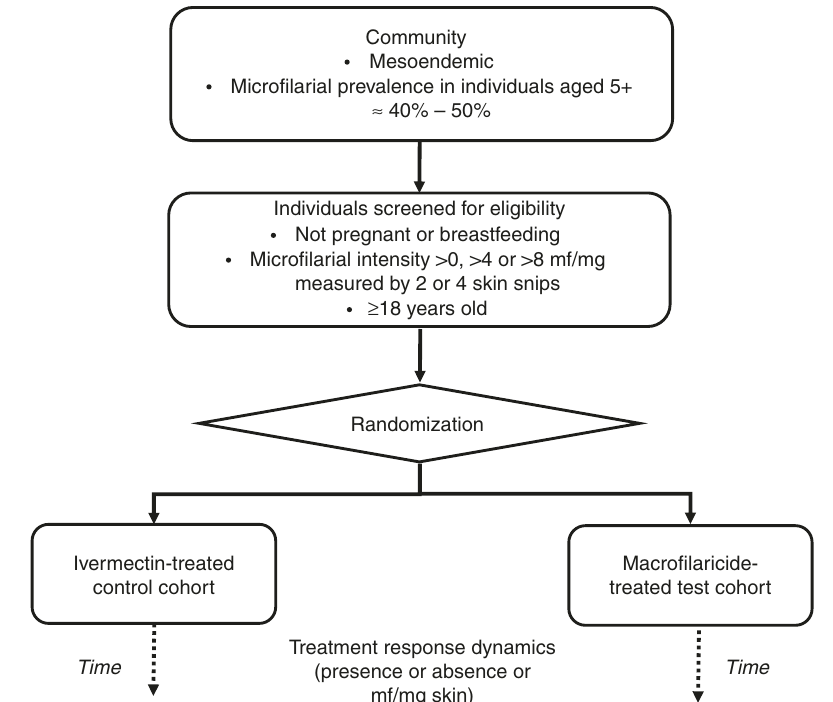
Fig. 1 Schematic representation of the simulated trial design. The simulated trial is conducted in a community previously ivermectin-naïve residing in a lower-end mesoendemic setting with a micro fi larial prevalence among individuals aged ≥ 5 years of 40% to 50%. It is assumed that all individuals are screened for eligibility to participate based on their age ( ≥ 18 years), their pregnancy and breastfeeding status, and their infection status (presence/absence of micro fi lariae, mf) and micro fi larial load (mf/mg) in the skin based on taking 2 or 4 skin snips. The presence and intensity (density) of mf in the skin, age, sex, and pregnancy and breastfeeding status of each individual are modelled using an adapted version of EPIONCHO-IBM, along with individuals ’ parasitological response to treatment with ivermectin or a hypothetical macro fi laricide that is macro fi laricidal only (MOM) or both macro fi laricidal and micro fi laricidal